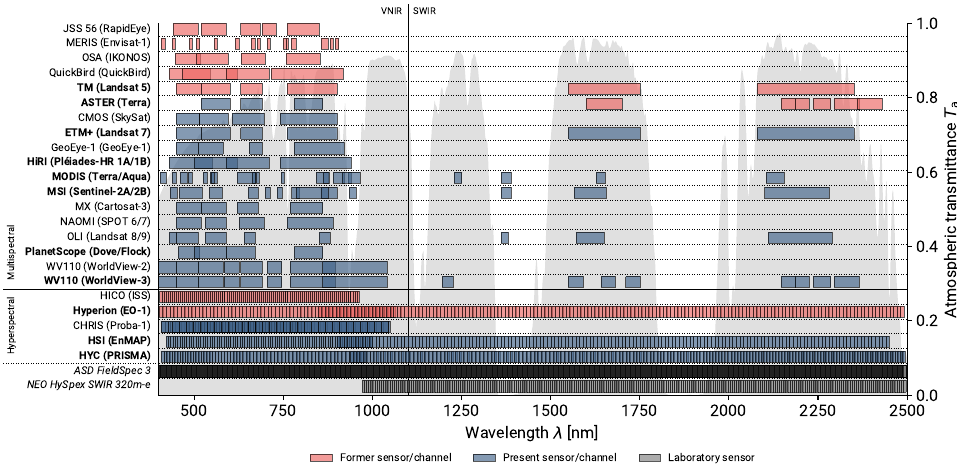
Figure 1. Channel constellations of optical spaceborne sensors (red and blue bars) and of the laboratory sensors used (gray bars). Bold-written sensors were selected for simulations. Earth’s transmission spectrum using MODTRAN is shown in gray